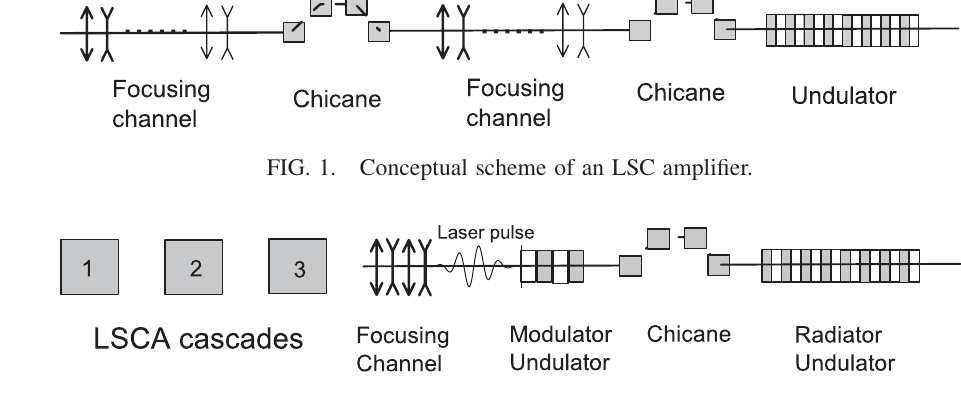
FIG. 2. LSCA-based attosecond scheme. Numbered boxes in the left part of the figure denote standard cascades of LSCA (focusing channel plus chicane).